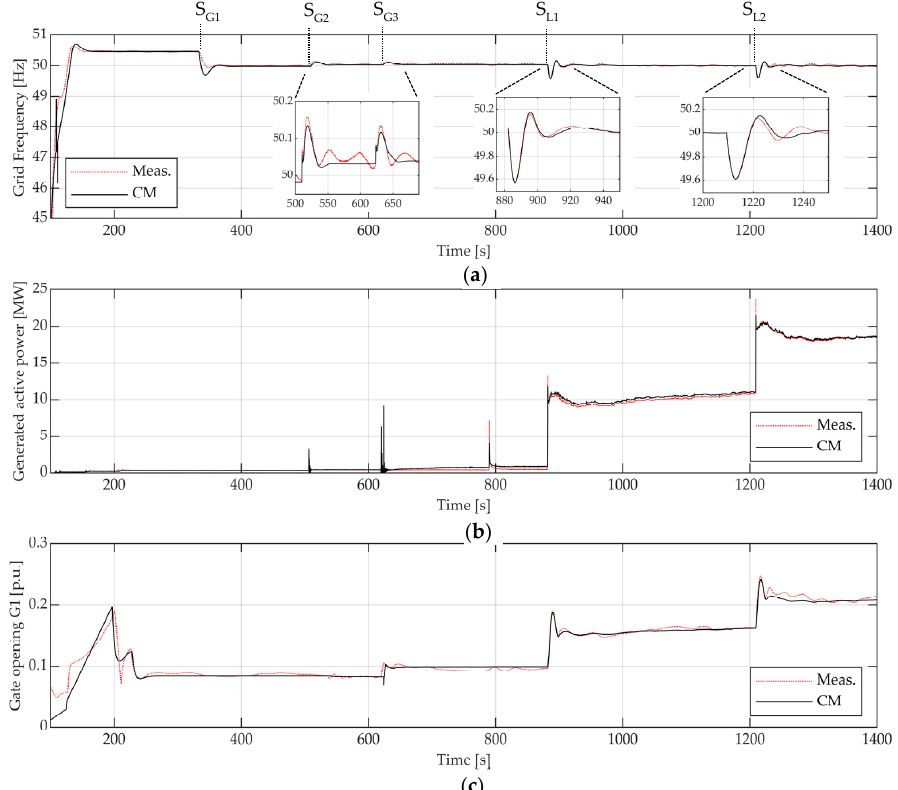
Figure 8. Comparison between simulation results and measurement recordings of the restoration test for ( a ) the grid frequency, ( b ) the generated active power and ( c ) the gate opening of G1.